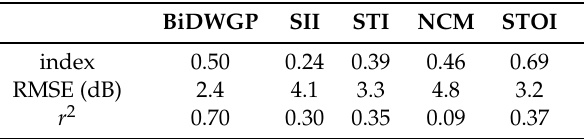
Table 1. Objective index leading to the minimal RMSE (in dB), RMSE and r 2 between the measured and predicted SBR min of five